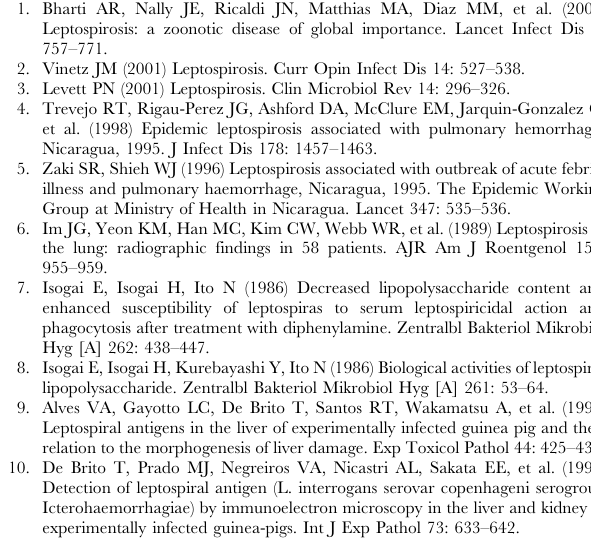
Figure S1 Purification of His-Tag fusion protein L-PAF-AH in the E. coli BL21 (DE3) pLysS cells monitored with the 15% SDS- PAGE. Lane 1, protein purified with Ni-NTA column from the soluble fraction in the bacterial lysate; lane 2, the molecular weight markers. Gel was stained with silver staining. Figure S2 DNA-sequence similarity comparison of l-paf-ah from L. interrogans serovar Lai strain 56601 (la2144) with that from the avirulent strain of L. interrogans serovar Lai (Avirulent Lai), L. interrogans serovar Javanica strain M 10 (Javanica), L. biflexa serovar Montevalerio (Montevalerio), L. interrogans serovar Linhai strain Lin 6 (Linhai), L. interrogans serovar Paidjan strain L 37 (Paidjan), L. interrogans serovar Pomona strain Luo (Pomona), L. interrogans serovar Hebdomadis strain P 7 (Hebdomadis), L. biflexa serovar Anhui strain Zong 7 (Anhui), L. interrogans serovar Canicola strain Lin (Canicola). Found at: doi:10.1371/journal.pone.0004181.s002 (8.36 MB TIF) Figure S3 Study design in gerbil leptospirosis model. Figure S4 PCR assay detection of leptospira on the 4th day in lung, heart, kidney, spleen and liver of gerbils inoculated with PBS, the avirulent strain of L. interrogans serovar Lai and L. interrogans serovar Lai. Lane 1, injected with PBS alone; lane 2, injected with the avirulent strain of L. interrogans serovar Lai; lane